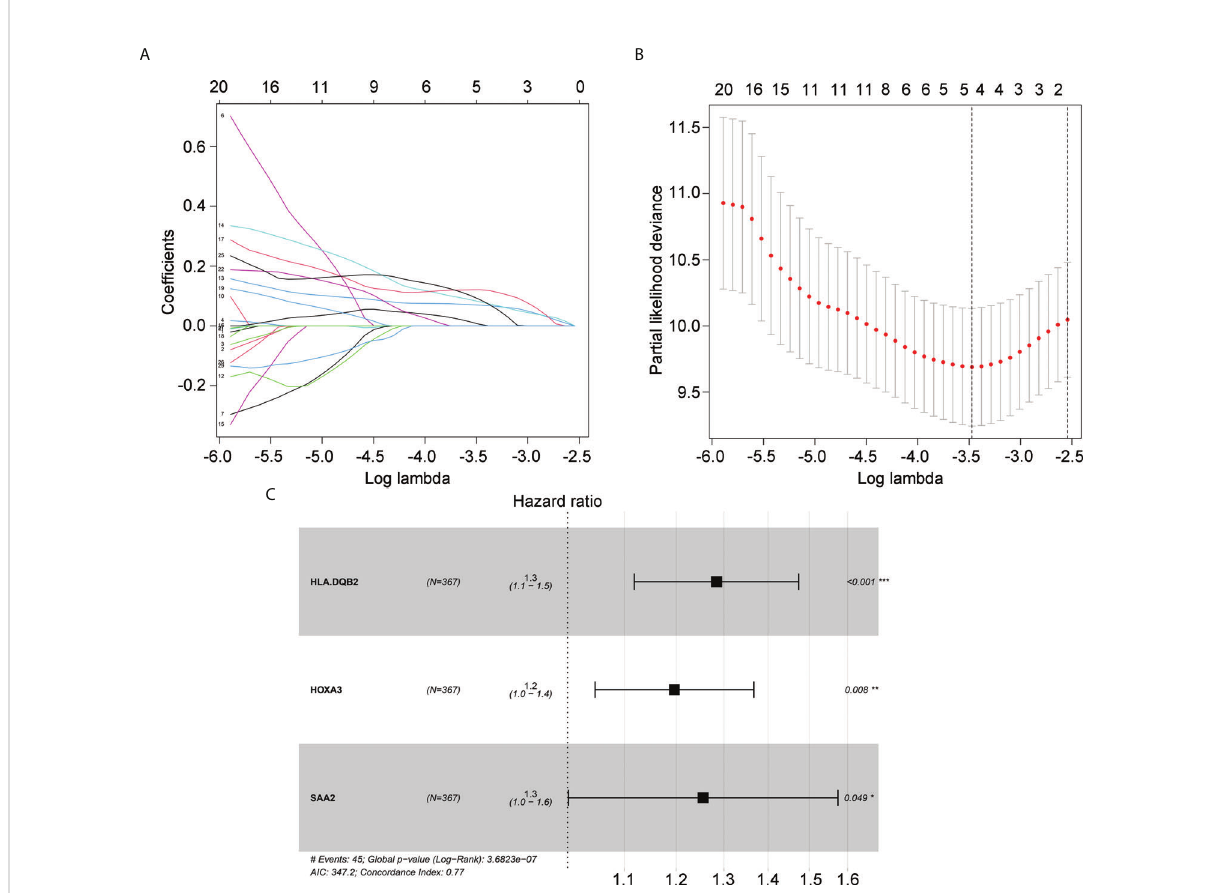
FIGURE 4 Hub genes selected to construct the risk model. (A, B) LASSO analysis for hub genes associated with the survival rate of IDH1mt-glioma patients. (C) Multivariate Cox regression analysis of HLA-DQA2 , HOXA3 , and SAA2. These three genes were used to construct the risk